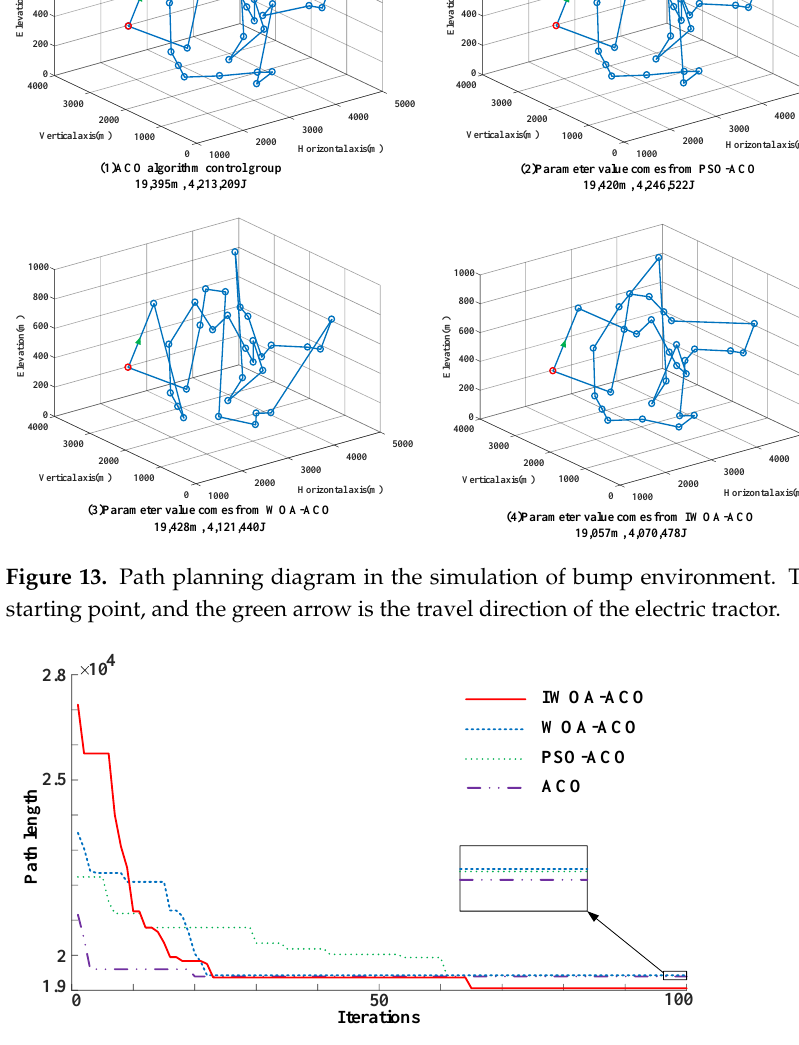
Figure 14. The iterative path length convergence curve in the simulation of bump environment. Table 5. The path length and energy consumption data in the simulation of flat